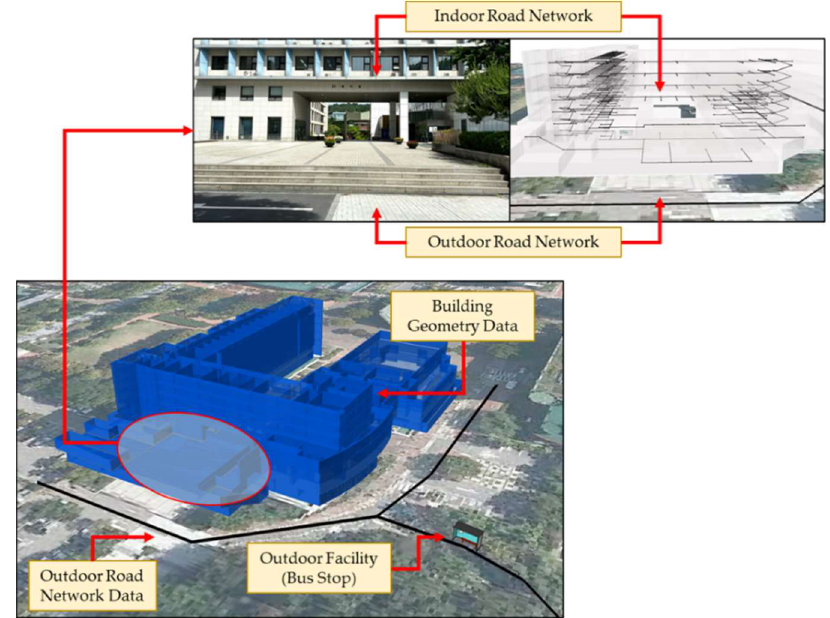
Figure 11. Plaza in front of Building A in the study area.